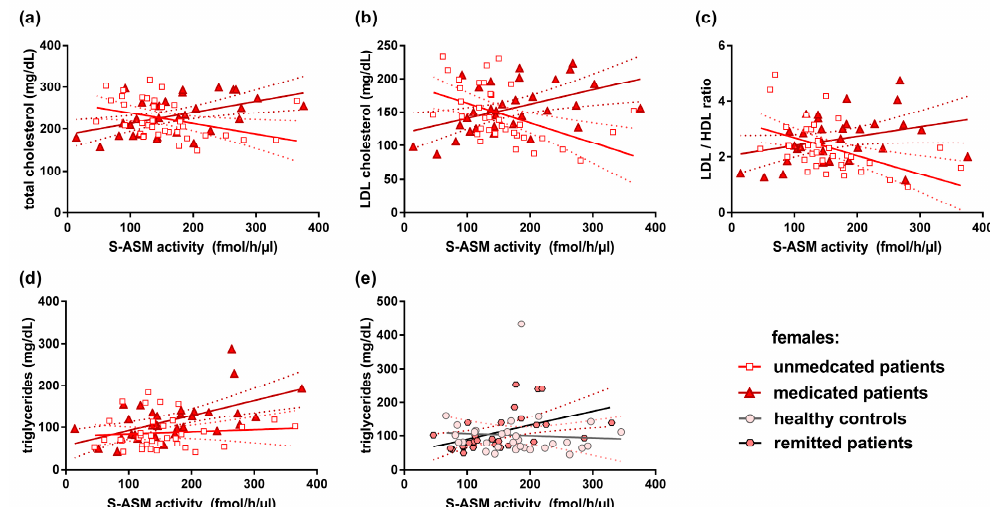
Figure 5. Correlation of serum acid sphingomyelinase (S-ASM) activity with serum lipids at the time of inclusion. High S-ASM levels were associated with total cholesterol ( a ), low-density lipoprotein (LDL) cholesterol ( b ), and ratio of low- to high-density lipoprotein cholesterol (LDL / HDL) ( c ) in unmedicated and medicated female patients and to total triglycerides in female medicated patients ( d ) and in female remitted patients ( e ). Individual data with linear regression line and 95% confidence intervals.